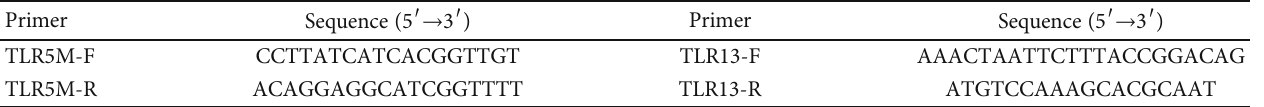
Figure 4: Gene expression pro fi les of TLR5M and TLR13. Their expression levels were normalized to that of β -actin and compared to their expression levels in the muscle. The results are presented as the mean ± SE of fold changes, and ∗ and ∗∗ indicate statistical signi fi cance at p < 0 : 05 ; ∗∗ p < 0 : 01 . Table 2: Primers used for gene expression analysis by qRT-PCR